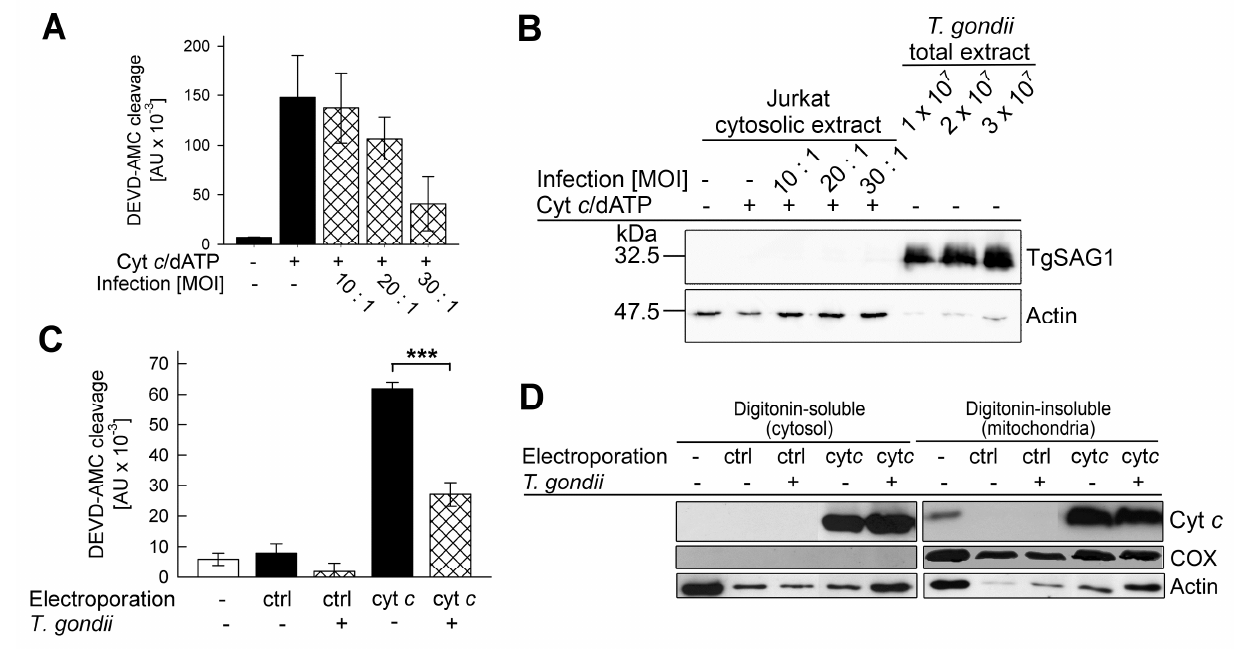
FIGURE 2: Infection of host cells with T. gondii diminishes in vitro and in vivo activity of caspase 3/7 triggered by exogenous cytochrome c . (A, B) Jurkat T cells were infected with increasing amounts of T. gondii (multiplicity of infection (MOI) 10:1 to 30:1; cross-hatched bars or as indicated) or were left non-infected (black bars or as indicated). (A) After 24 hours of infection, cytosolic extracts were isolated and the caspase cascade was activated using cytochrome c /dATP. Caspase 3/7 activity was determined by fluorimetric measurement of DEVD-AMC cleavage over time. Results represent means ± S.E.M. (n=3). (B) Alternatively, the cytosolic extracts from Jurkat cells and total extract from the same numbers of parasites as having been used for infection were separated by SDS-PAGE and analyzed by immunoblotting using anti- bodies which recognize T. gondii SAG1 or host cell actin. Bound antibodies were visualized using peroxidase-conjugated secondary antibodies and enhanced chemiluminescence detection. Results are representative for two independent experiments. (C) Jurkat cells infected with T. gondii for 1 hour (MOI 30:1; cross-hatched bars) and non-infected control cells (open bar and black bars) were electroporated in the pres- ence of cytochrome c (cyt c ) or bovine serum albumin (ctrl) or were left non-treated. After incubation of the cells and subsequent cell lysis, caspase activity was determined by fluorimetric measurement of the cleavage of the caspase 3/7 substrate DEVD-AMC. Data represent the increase of cleavage over time; bars indicate means ± S.E.M. (n=6). Significant differences were identified by Student’s t -test (*** P < 0.001). (D) After infection and/or electroporation of cells as described above (C), cells were partitioned into a digitonin-soluble fraction comprising the host cell cytosol and a digitonin-insoluble fraction including mitochondrial proteins. Proteins were resolved by SDS-PAGE and after trans- fer to nitrocellulose, were immunolabelled using antibodies recognizing cytochrome c (cyt c ), cytochrome c -oxidase subunit IV (COX) or actin. Immune complexes were visualized using peroxidase-conjugated secondary antibodies and enhanced chemiluminescence detection. Similar results were obtained in two independent